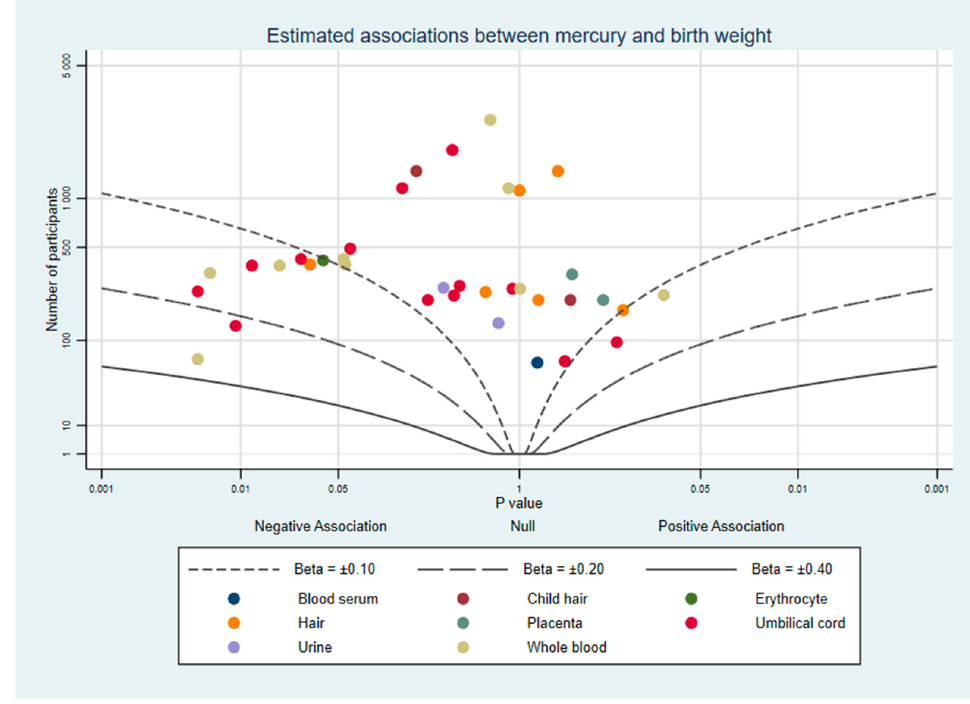
Figure 2. Albatross plot of the estimated effect of mercury exposure on birth